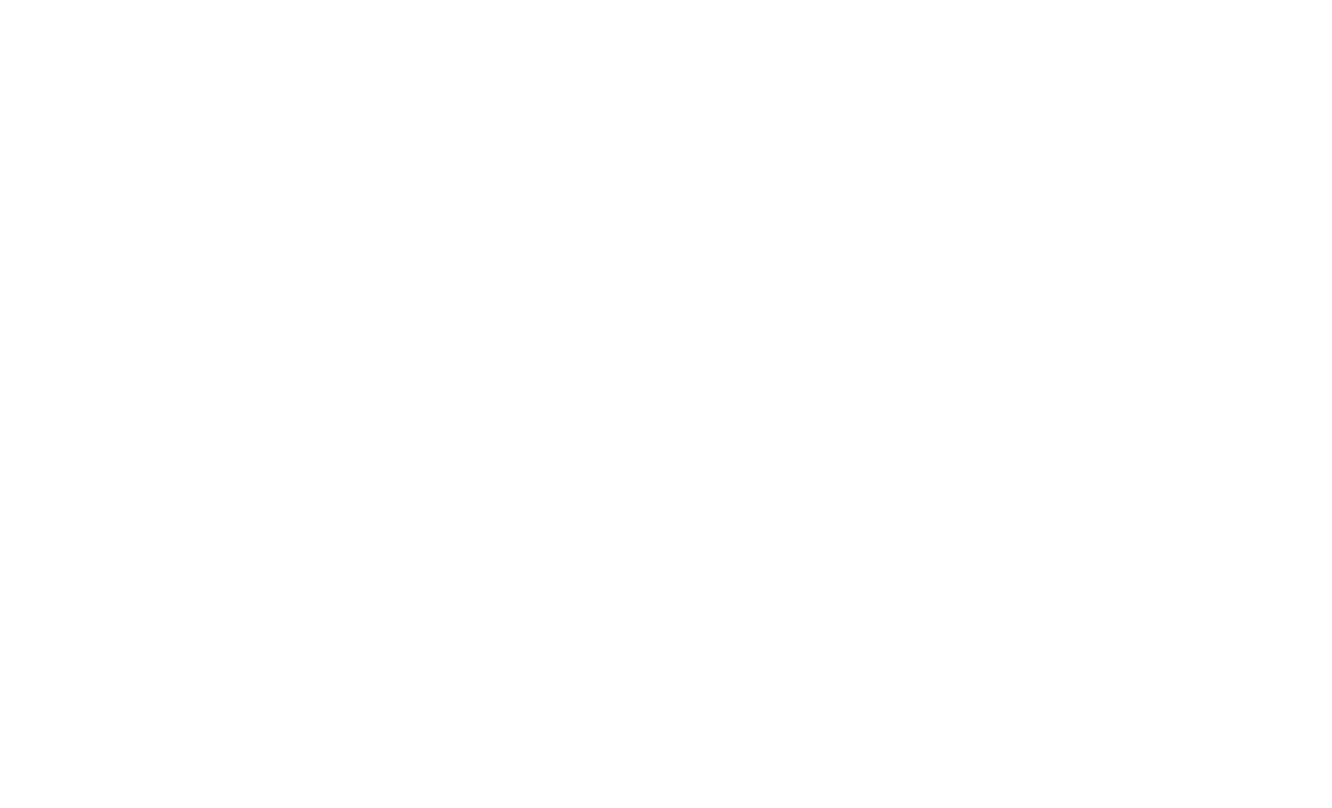
Frontiers in Immunology |T Cell Biology December 2011 |Volume 2 | Article 75 |